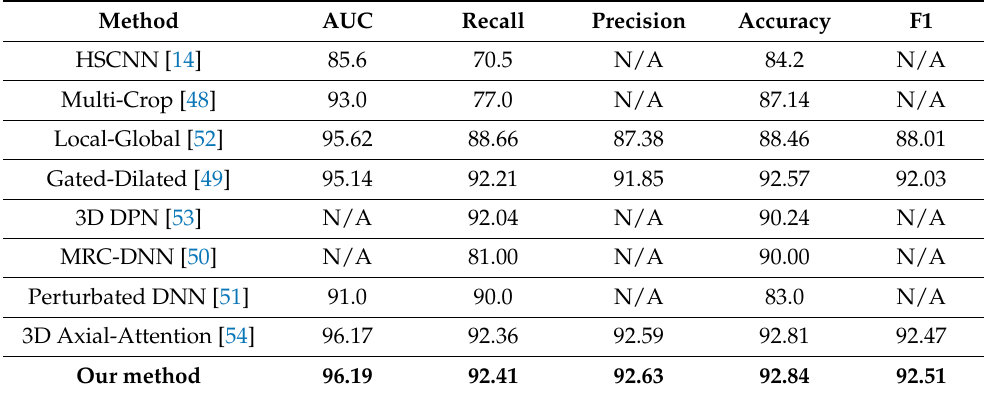
Table 2. The proposed method’s performance compared to the state-of-the-art